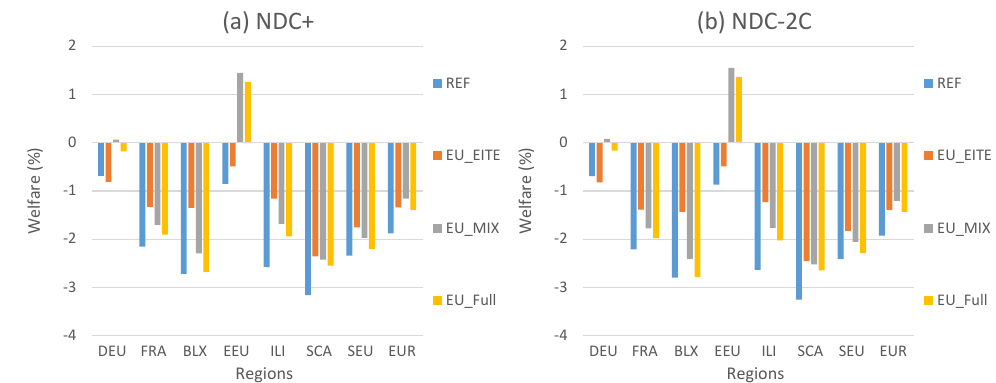
Figure A1. Percentage change in welfare for policy scenarios under the IEO baseline for the NDC+ and NDC-2C